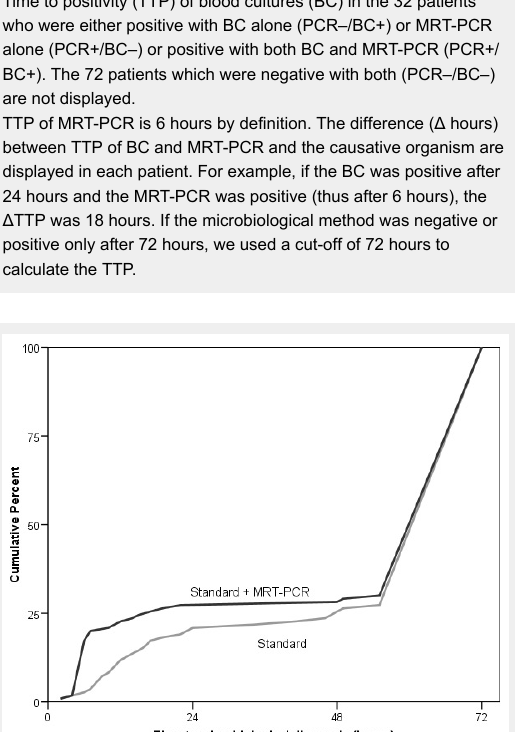
Time to microbiological diagnosis. Cumulative frequency distribution curve for the time to microbiological diagnosis during the first 72 hours with conventional microbiological methods (“standard”) compared to the multiplex real-time polymerase chain reaction (MRT-PCR). The microbiological diagnosis of the causative organism was achieved significant earlier with the combination of MRT-PCR and conventional microbiological methods compared to the conventional microbiological methods alone (Wilcoxon p ≤0.001). The median time gained until microbiological diagnosis was 3.9 hours (range